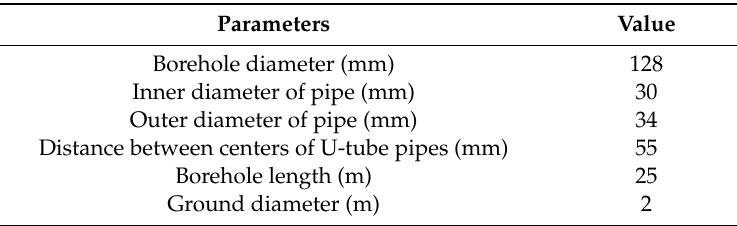
Table 1. Geometric properties of U-tube ground heat exchanger (GHE).